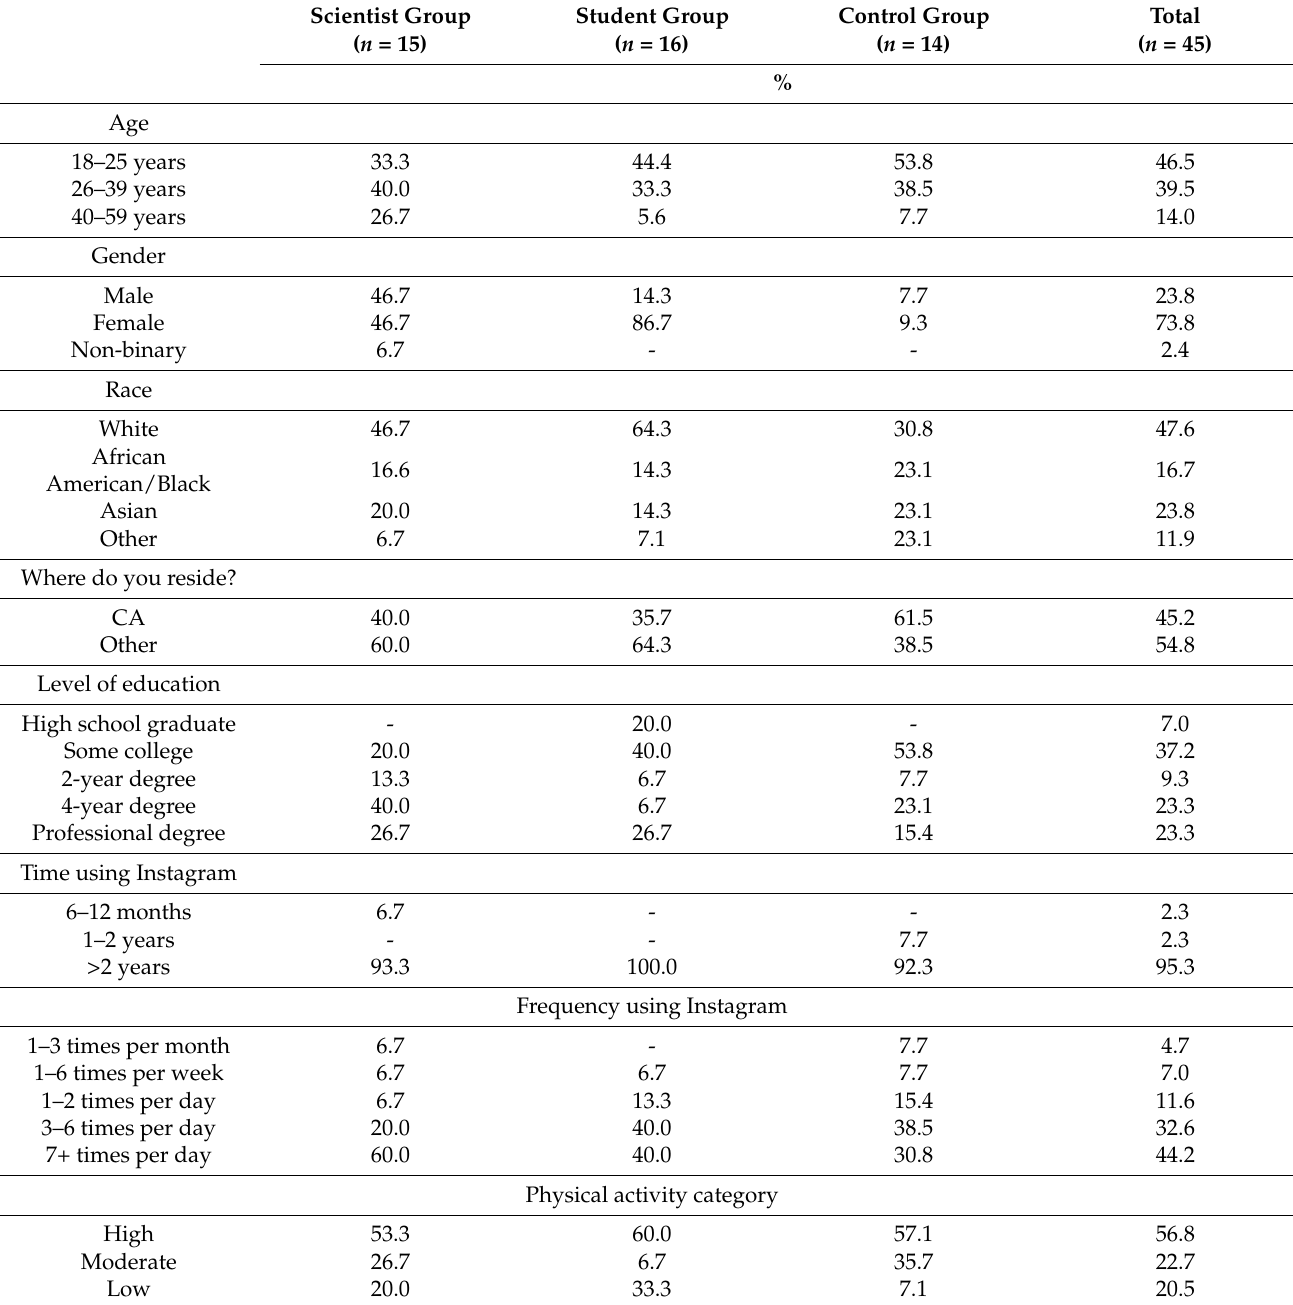
Table 2. Participant